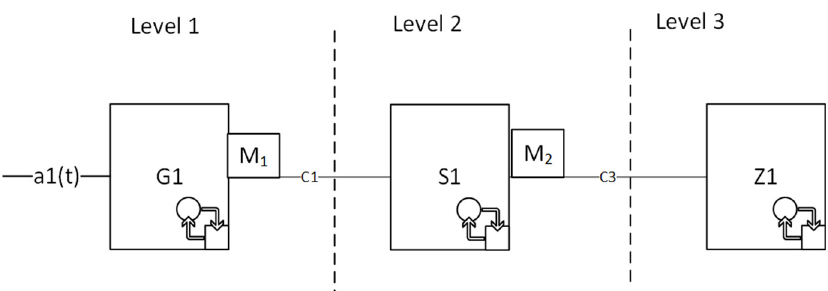
Figure 2. Dedicated logical transmission channel in a control system.